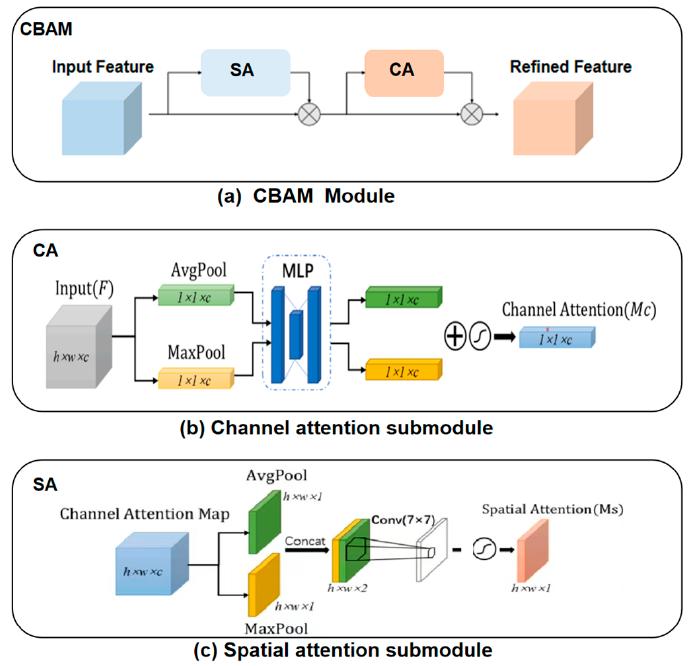
Figure 3. Structure of the CBAM module.